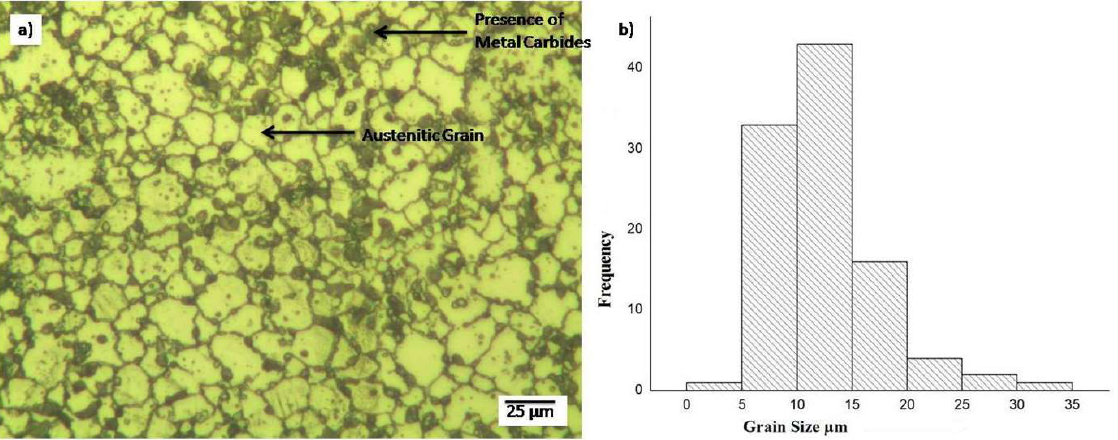
Figure 5. Optical micrograph of ( a ) 21-4N, ( b ) corresponding grain size.